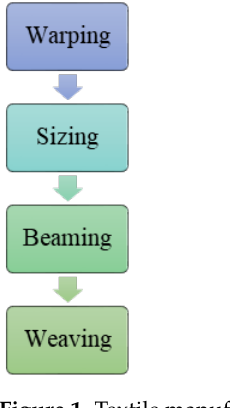
Figure 1. Textile manufacturing process.